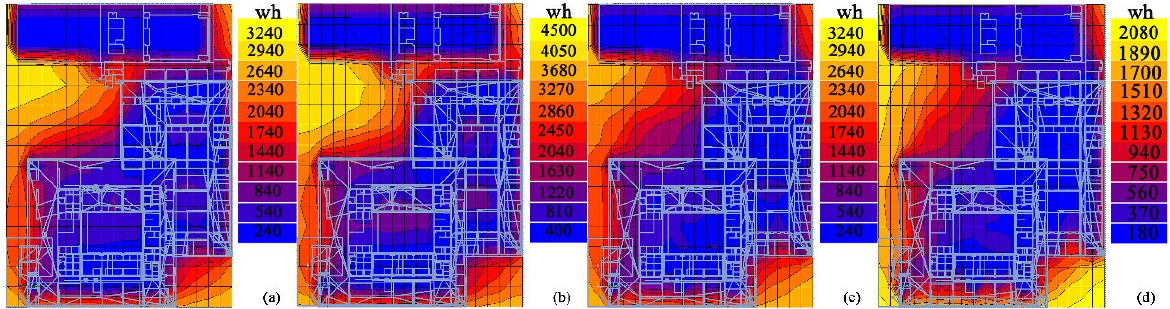
Figure 3. Spatial distribution of solar radiation in spring ( a ), summer ( b ), autumn ( c ), and winter ( d